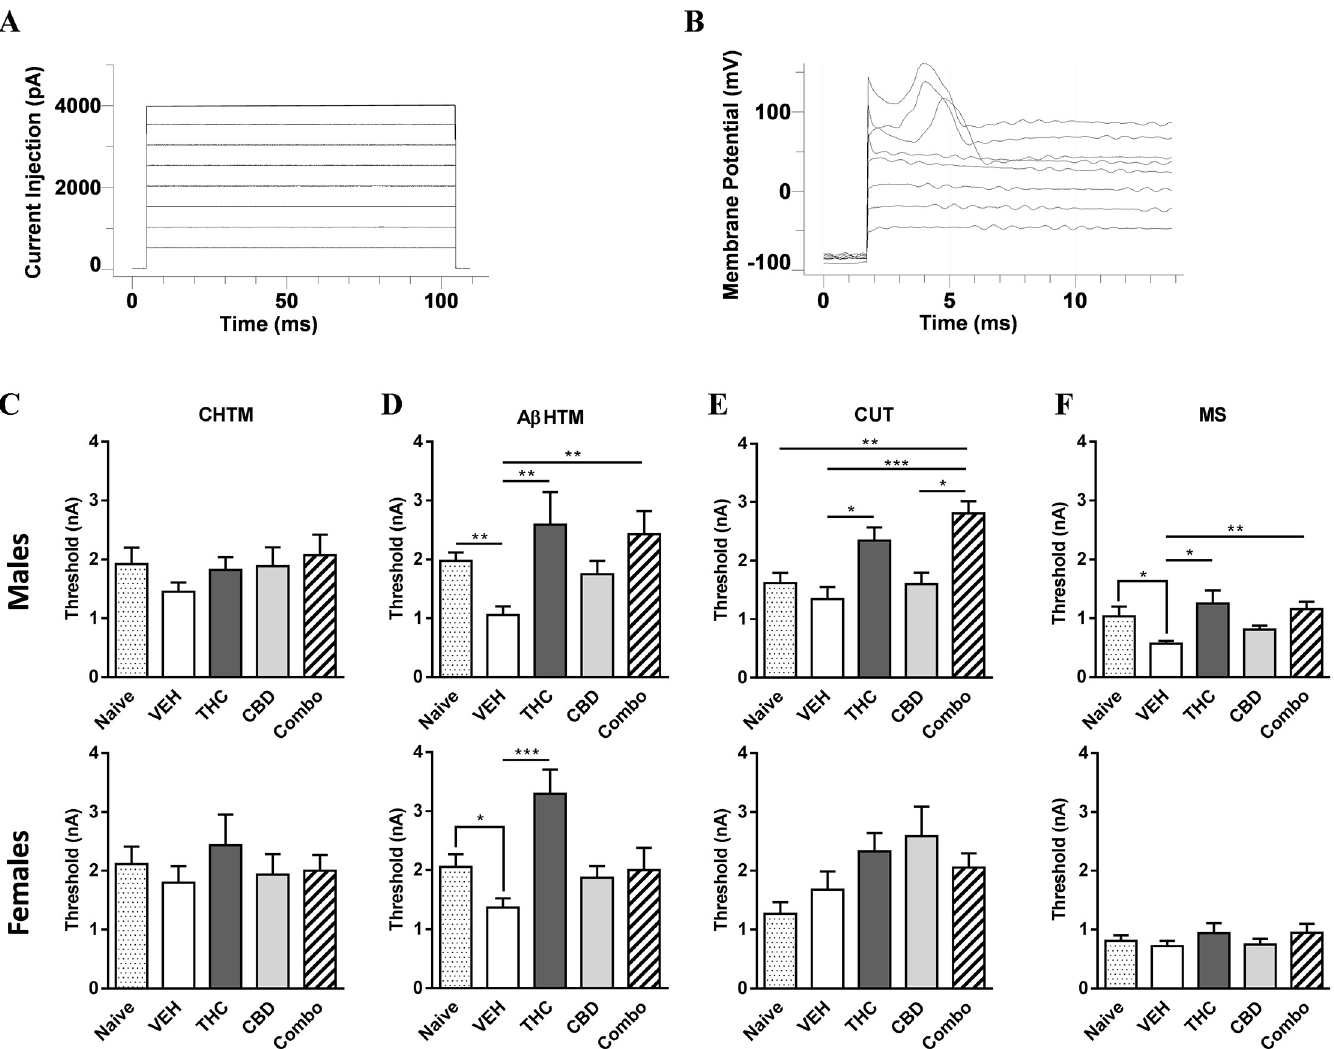
Fig 3. A comparison of the in vivo activation threshold of sensory neurons of nerve cuff-bearing rats in response to early cannabinoid treatment relative to naive animals. Electrophysiological recordings were captured seven weeks after cannabinoid administration had ceased. A) The activation threshold was measured by evoking action potentials (AP) in the soma of L4 DRG neurons using stimulation by direct injection of depolarizing current; X-axis: Time (ms), Y-axis: current (pA). B) Representative raw recordings performed on male A β HTM neurons in the 1:1 THC to CBD combination (Combo)-treated group. X-axis: Time (ms), Y-axis: Voltage (mV). The threshold of C) C HTM, D) A β HTM, E) A β LTM CUT, and F) A β LTM MS fibers, recorded in males and females. C-F) The current threshold was defined as the minimum current required to evoke an AP by intracellular injection. Data are expressed as the mean threshold ± SEM for each treatment group. Differences between treatment groups were compared using the Kruskal-Wallis test with a Dunn’s multiple comparison post hoc test; stars ( � ) with a corresponding line between groups indicate the level of significance ( � P < 0.05, �� P < 0.01, ��� P < 0.001). A bracket indicates significance determined via a Mann-Whitney t-test to compare between na ï ve and VEH-treated groups within a given sex ( � P < 0.05). HTM: high threshold mechanoreceptor, LTM: low threshold mechanoreceptor, CUT: A β LTM cutaneous neuron, MS: A β LTM muscle spindle neuron.